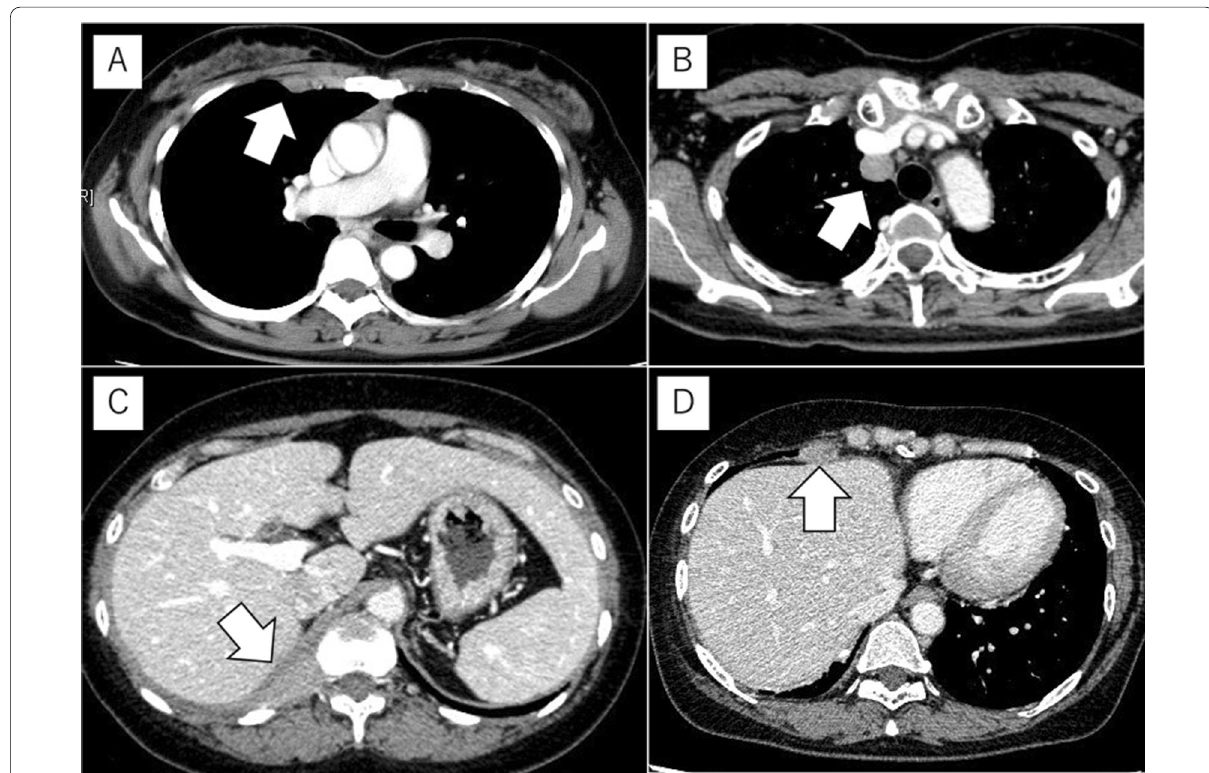
Fig. 2 Chest computed tomography (CT) imaging of the disseminated pleural nodules seen in the postoperative recurrence of thymic carcinoma (arrows). A CT taken during the 3rd postoperative year. A nodule is noted on the anterior chest wall. B , C CT taken during the 10th postoperative year. A nodule is observed right behind the right brachiocephalic vein ( B ) and at the crus of the diaphragm ( C ). D CT taken during the 16th postoperative year. A nodule is shown between the anterior chest wall and the diaphragm